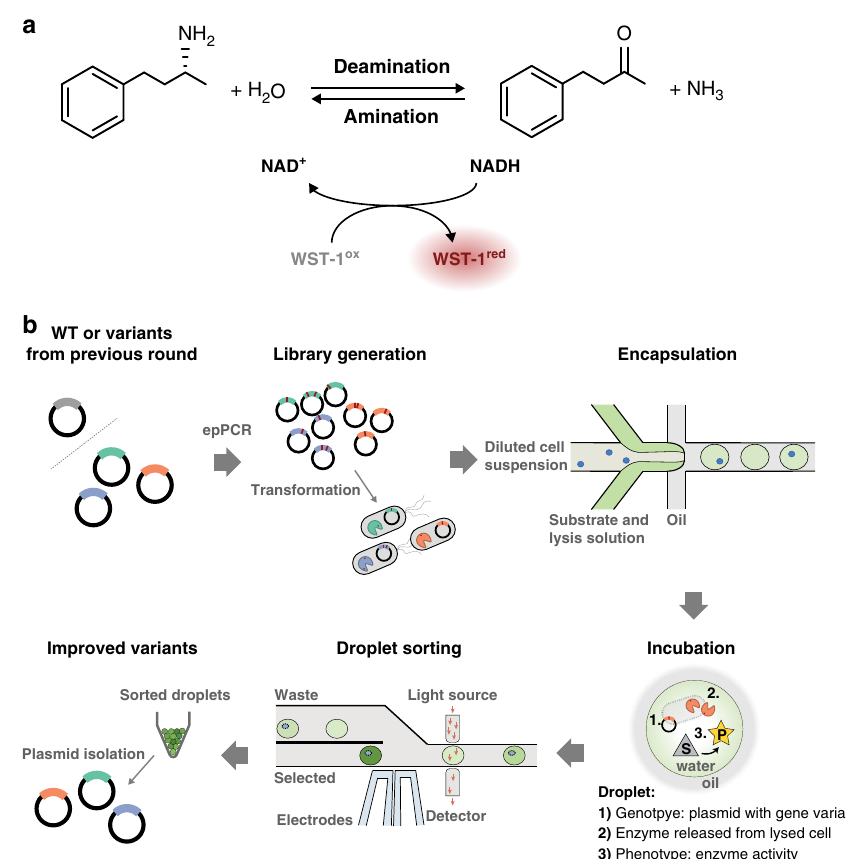
Fig. 2 Ultrahigh-throughput droplet micro fl uidic evolution of an amine dehydrogenase (AmDH) biocatalyst. a Coupled reaction to measure AmDH activity in droplets. The enzyme AmDH catalyzes the deamination of ( R )-1-methyl-3-phenylpropylamine to 4-phenyl-2-butanone, thereby reducing NAD + to NADH and releasing NH 3 . NADH is regenerated upon reduction of WST-1, mediated by 1-methoxy-5-methylphenazinium methyl sulfate (mPMS). Reduced WST-1 exhibits absorbance at 455 nm, which is detectable by absorbance-activated droplet sorting (AADS) on chip 38 . b A cycle of directed evolution using absorbance-activated droplet sorting (AADS). Generation of diversity by error-prone PCR was followed by transformation and compartmentalization of cells in droplets. Cell lysis upon droplet formation liberates AmDH and reaction progress was determined based on the formation of colored downstream product in a coupled reaction. The best ~0.5% of variants in the library were selected by AADS and the respective plasmid pool was